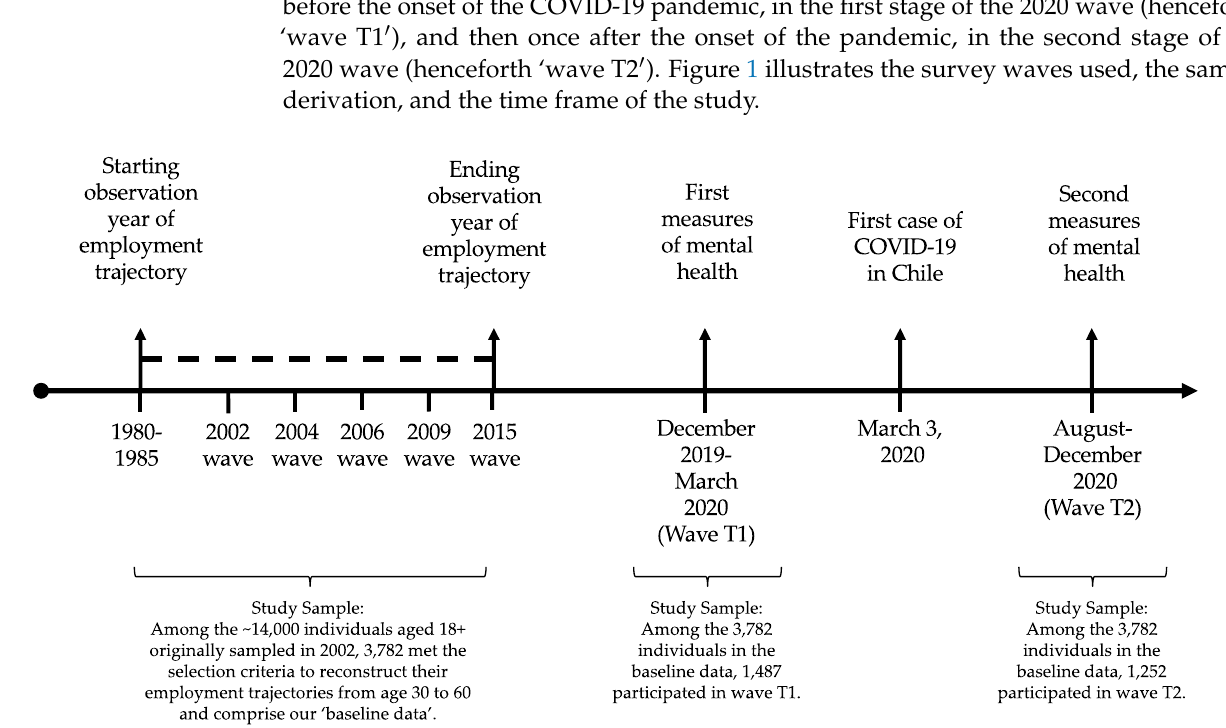
Figure 1. Survey waves used in this study and sample derivation.